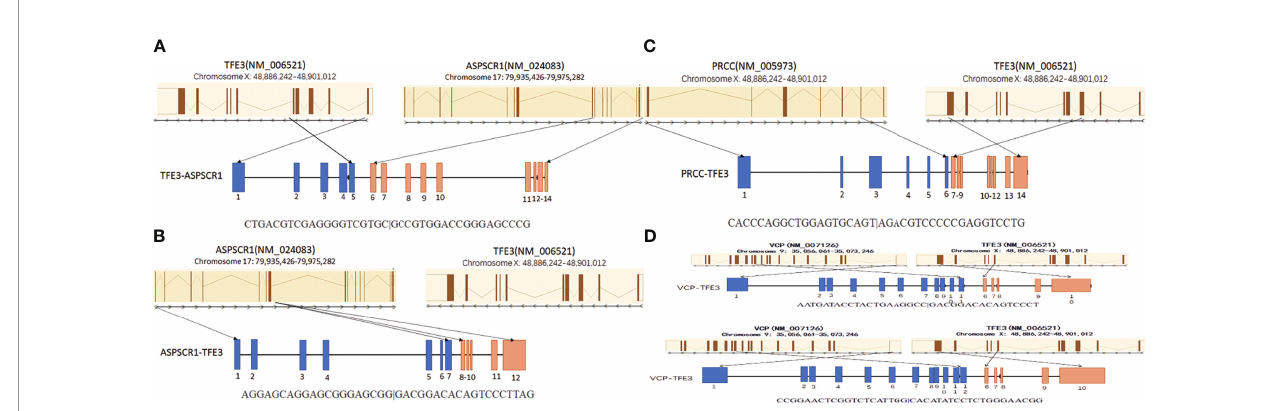
FIGURE 2 | Schematic diagrams of the TFE3 fusion transcripts with their partner genes in our cohort. (A) The ASPL – TFE3 rearrangement between genes ASPL exon 8 and TFE3 exon 5. (B) The ASPL – TFE3 rearrangement between genes ASPL exon 7 and TFE3 exon 6. (C) The PRCC – TFE3 rearrangement between genes PRCC exon 6 and TFE3 exon 3. (D) There are two VCP – TFE3 fusion types: one between VCP exon 11 and TFE3 exon 6 and the other between VCP exon 12 and TFE3 exon